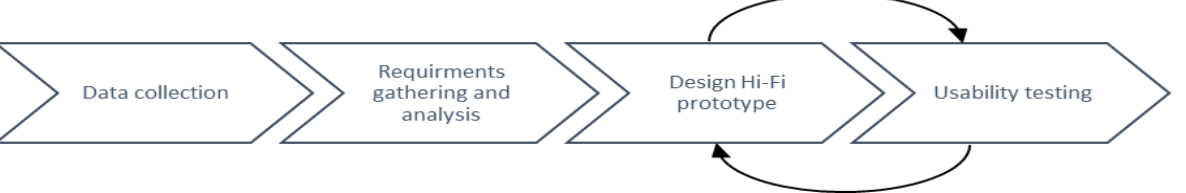
Figure 2. The methodology for developing a multimodal data visualization framework.